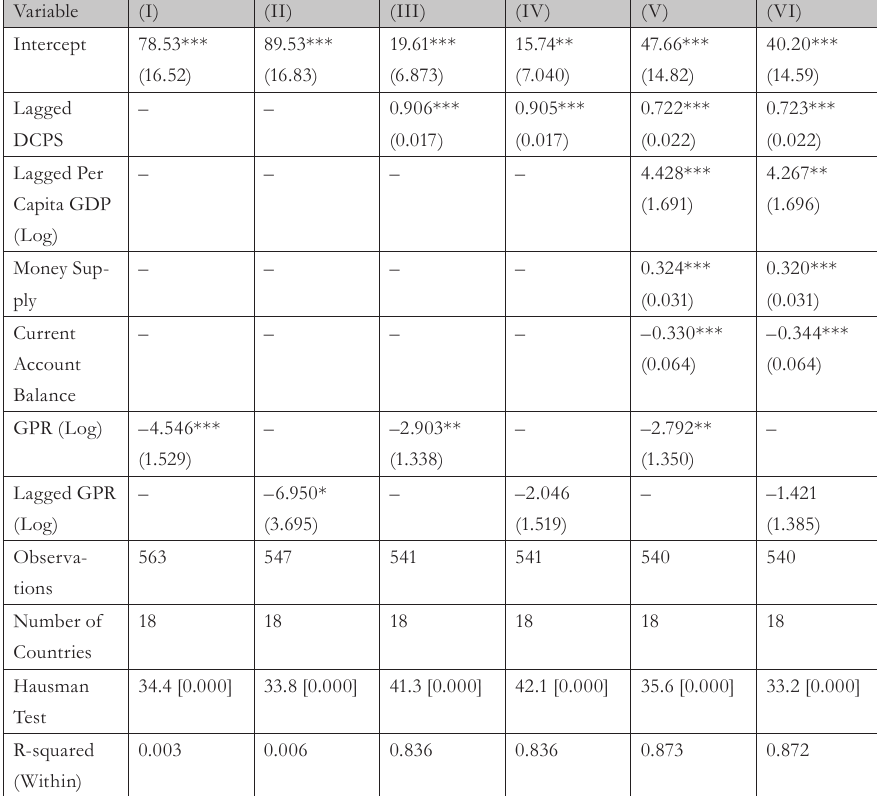
Tab. 3 – Results of the fixed-effects estimations (1985–2018). Source: own